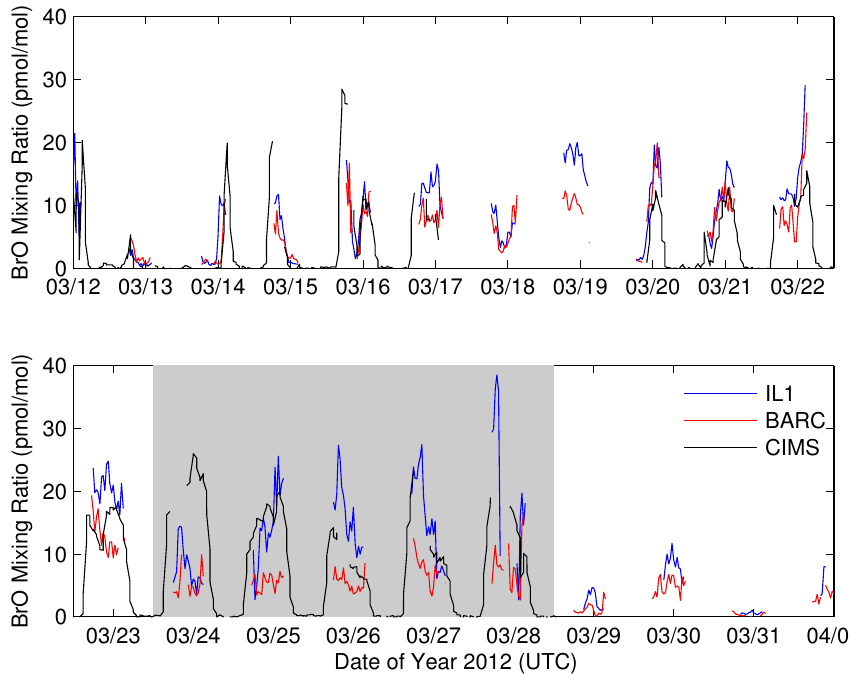
Figure 6. A time series of 30min averaged BrO measured using CIMS, compared with average BrO in the lowest 100m measured by MAX- DOAS at two different sites. The gray area indicates times when there were significant differences in BrO observed between MAX-DOAS sites at the BARC building and on land fast ice 36km NE of the BARC building